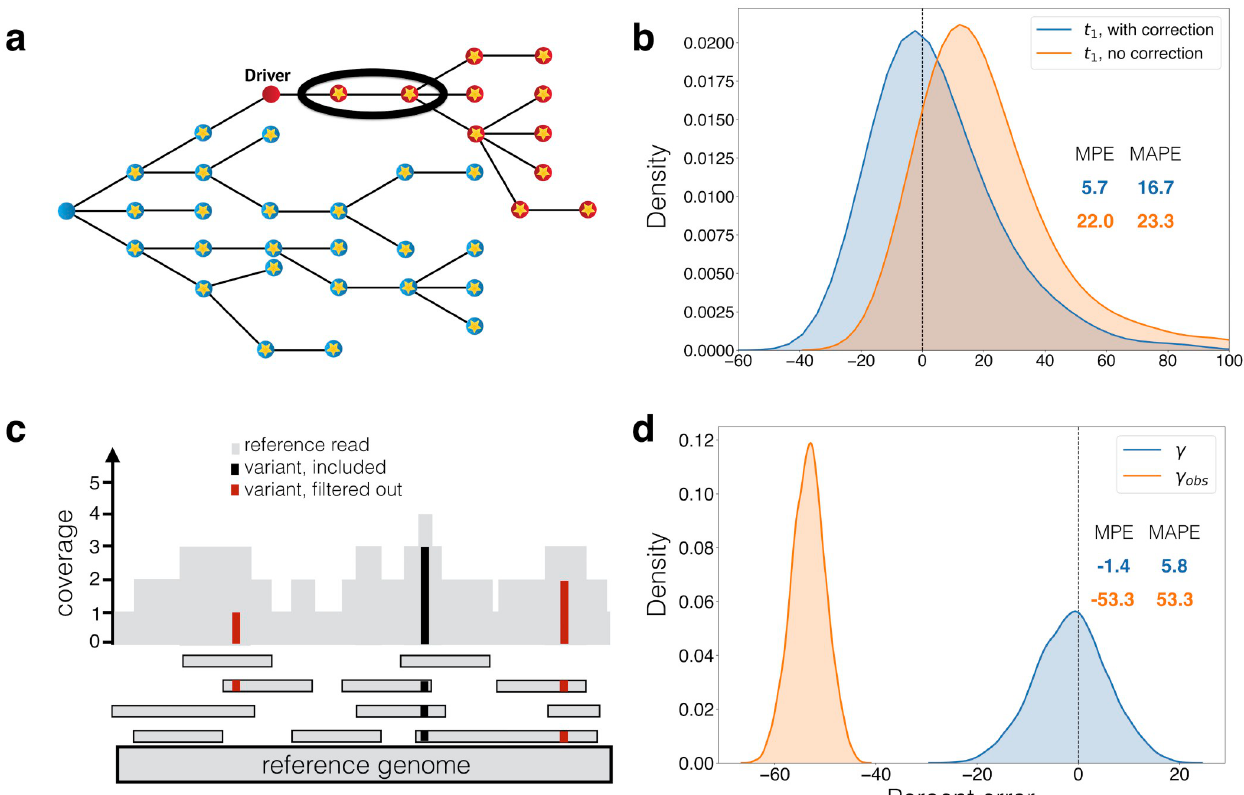
Fig 3. Corrections for observed mutation counts. (a) If passenger mutations (circles with stars) that occur after the driver reach fixation in the driver population (red), then they are indistinguishable from the passengers that were present in the first cell with the driver, which accrued in the type-0 population (blue). The estimate of when the driver occurred needs to account for these mutations (circled). In (b), we compare percent errors of parameter estimates for time from tumor initiation until appearance of a driver subclone, t 1 , with and without this correction (Eq (6)). Errors for estimate with correction are shown in blue, and for estimate without correction (Eq. (5)) in orange. Errors are plotted as a kernel density estimate for Monte Carlo simulations of slow-growing tumor with mutation rate u = 5. Mean percent errors (MPEs) and mean absolute percent errors (MAPEs) are listed. (c) Mutations present on two or fewer variant reads (red) are filtered out in post-processing. Mutations with more than two variant reads (black) are included. The number of subclonal mutations between frequencies f 1 and f 2 , γ , which is used in the mutation rate estimate, must be corrected for mutations that are filtered out. In (d), the percent errors for the observed (orange) and corrected (blue) γ (Eq (7)) are plotted as kernel density estimates. Observed mutations are those that passed post-processing, i.e. those that have more than L = 2 mutant reads. True mutation frequencies were generated from 135 surviving runs of a Monte Carlo simulation of a fast- growing tumor with mutation rate u = 1, from which sequencing reads were simulated with 200x average coverage (see Materials and methods). Percent errors are calculated relative to the true γ measured from the true mutation